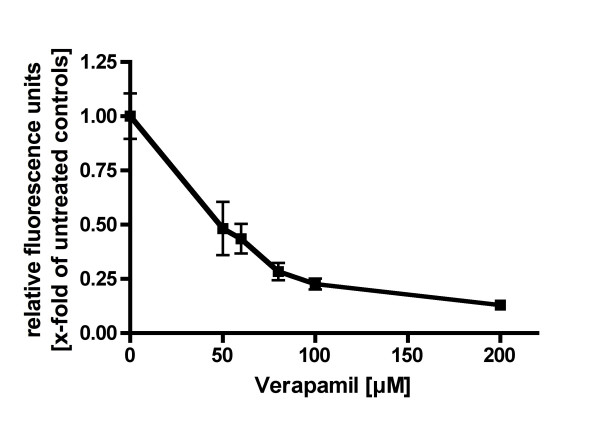
Verapamil is an inhibitor of 26S proteasome function. Incubation of crude extracts of ECV304 cells containing proteasomes with different doses of verapamil (50, 60, 80, 100, 200 μM) inhibited proteolysis of the chymotrypsin-like substrate SucLLVY-AMC in a dose-dependent manner, indicating inhibition of 26S proteasome function.